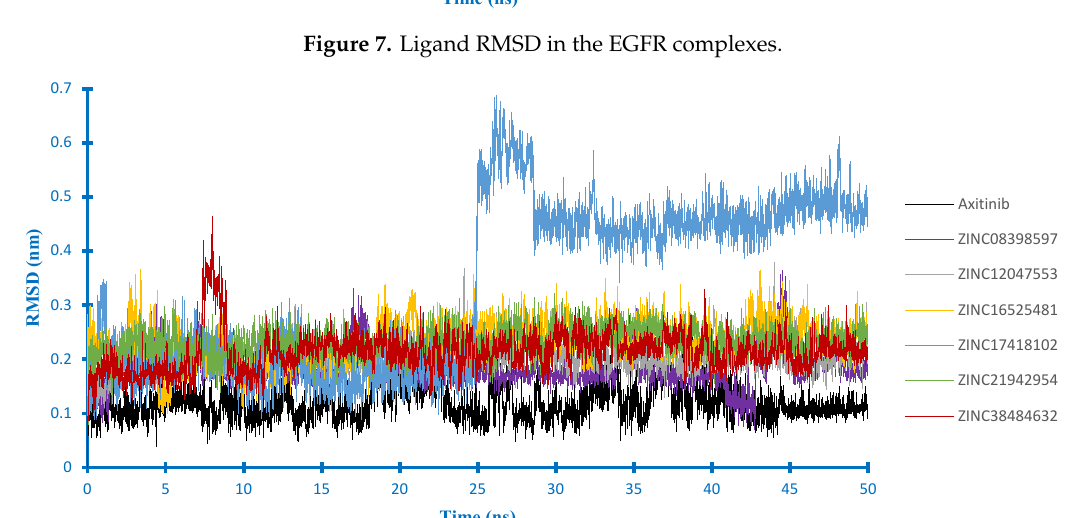
Figure 8. Ligand RMSD in the VEGFR2 complexes. Figure 7. Ligand RMSD in the EGFR complexes.